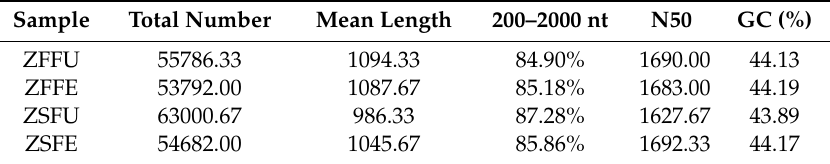
Table 2. Overview of unigenes quality in four